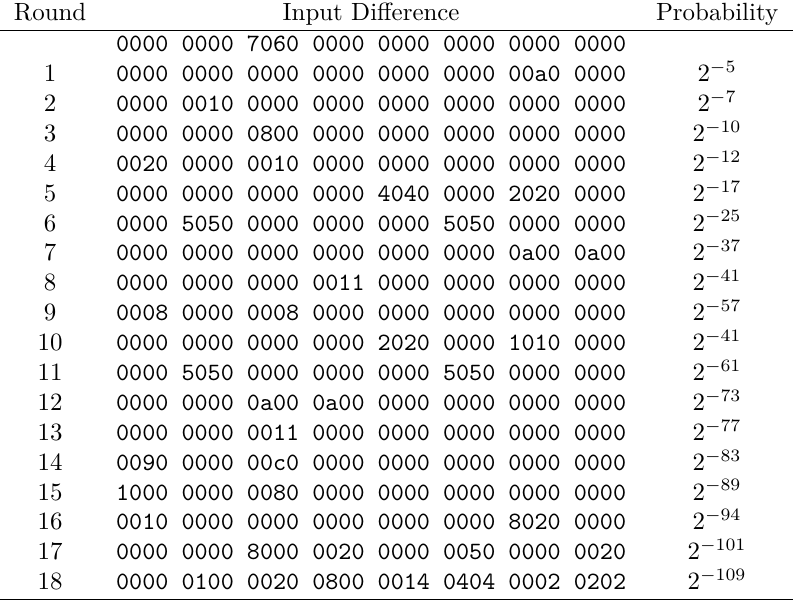
Table 4: 18-Round Sparse Differential Trail by Zhu et al. [ZDY19, Table 10] Round Input Difference